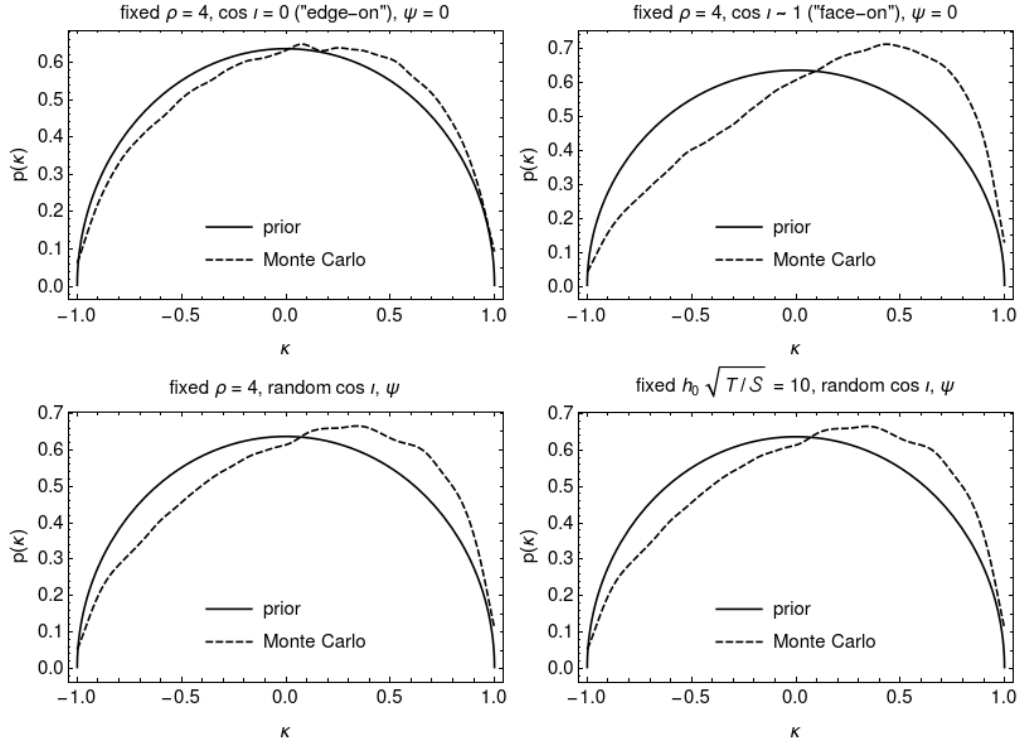
) overlay those for . F F